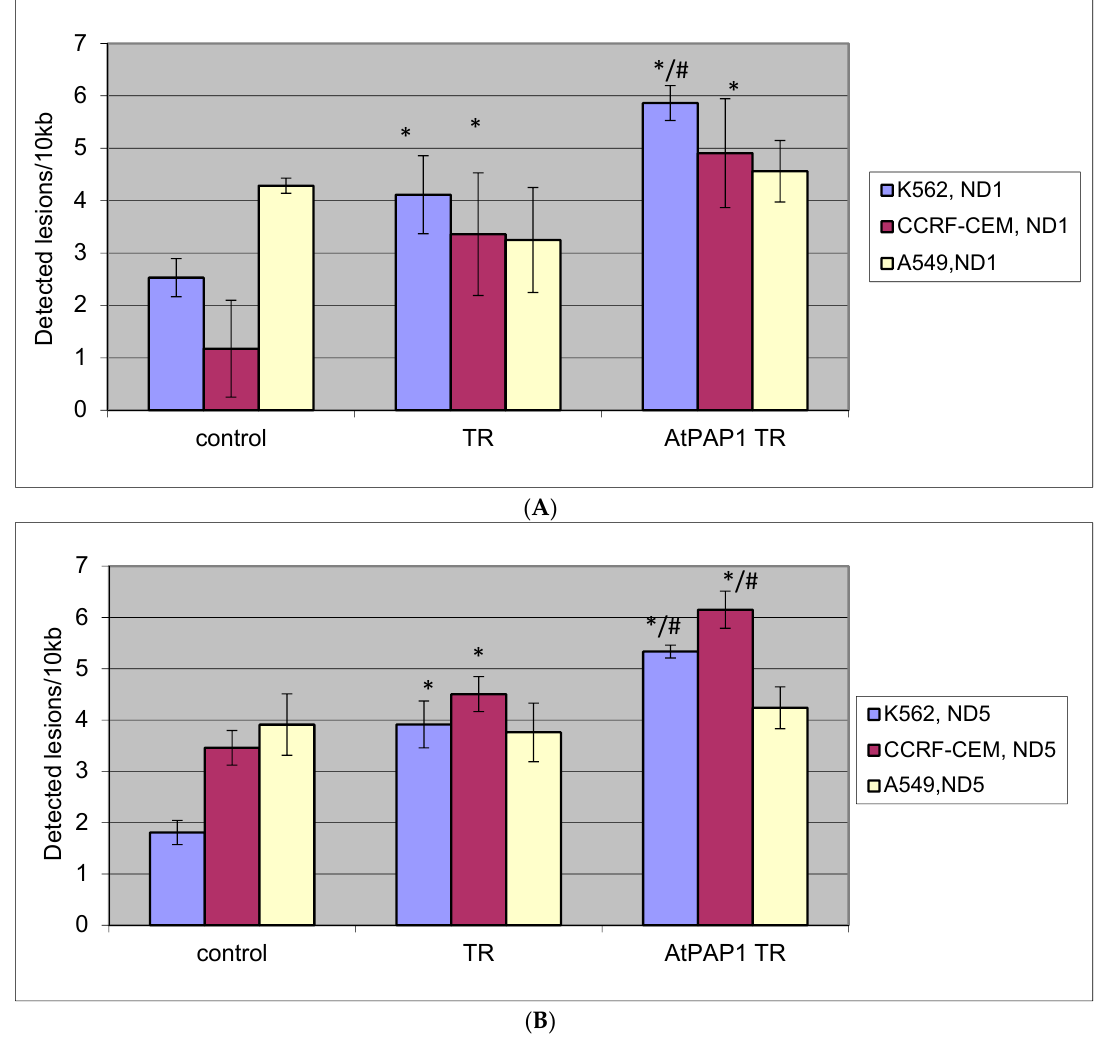
Figure 4. The effect of TR and AtPAP1 TR root extracts of L. sibiricus on mitochondrial DNA (mtDNA) lesion frequency per 10 kb DNA in ( A ) ND1 and ( B ) ND5 genes, estimated by SLR-qRT-PCR amplification of total DNA from CCRF-CEM, K562 and A549. The data represent means ± SD. *: p < 0.05 Control vs. TR and AtPAP1 TR. #: p < 0.05 TR vs AtPAP1 TR.